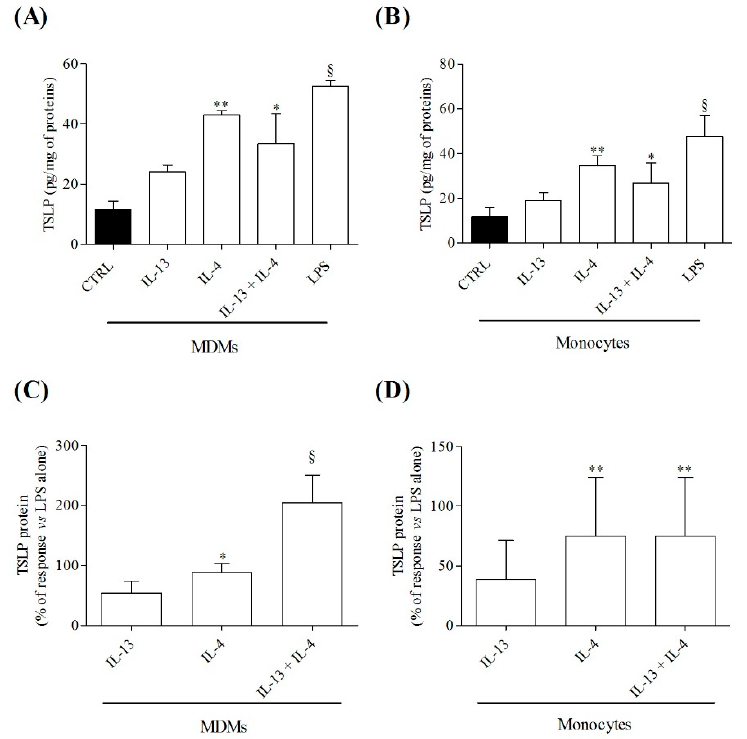
. Figure 5. Effects of IL-13, IL-4, alone or in combination, and of LPS on TSLP production by